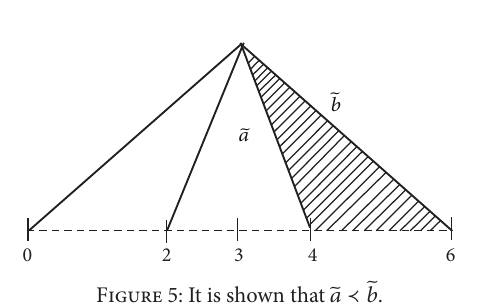
Figure 5: It is shown that ̃𝑎 ≺